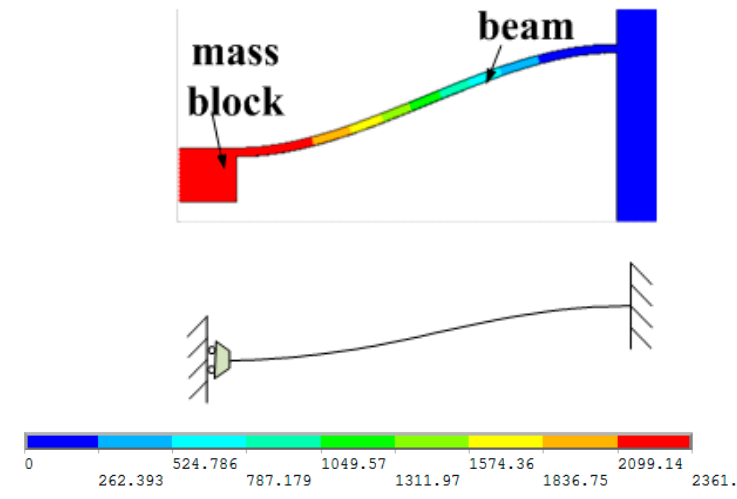
Figure 4. Microstructure mechanics model.